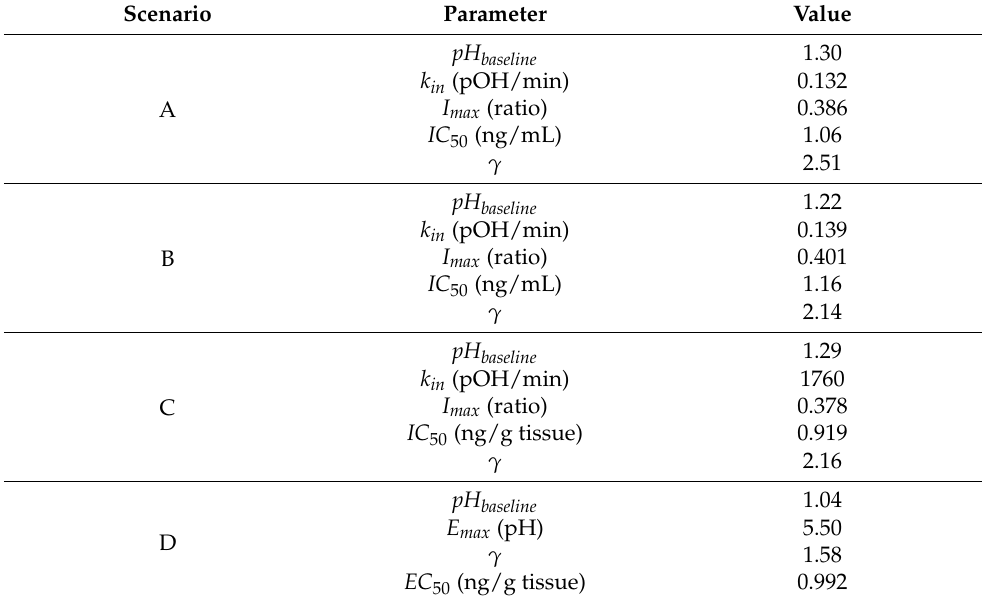
Table 3. Estimated parameters for the fexuprazan PD models. Four combinations of PK–PD models were attempted. Unbound concentrations in plasma (Scenarios A and B) and stomach (Scenarios C and D) were used as input functions. The PK–PD models were designated Scenarios A, B, C, and D. Detailed descriptions of the PK–PD models are described in the text.